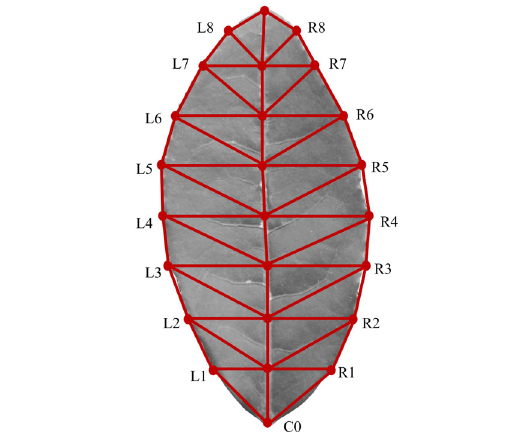
Figure 6. Matching schematic diagram of the tea leaf.